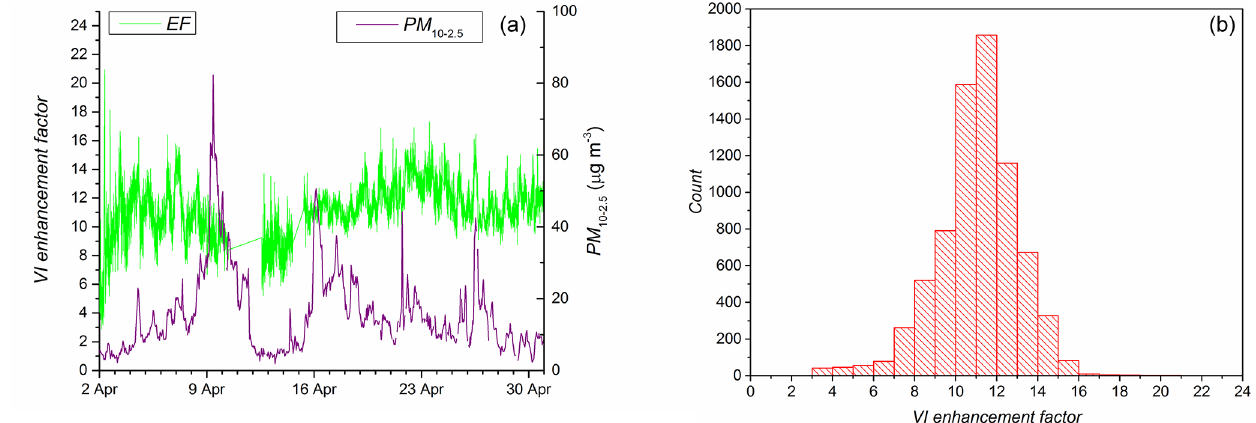
Figure 5. Time series of the virtual impactor enhancement factor calculated from aerodynamic size distributions measured by APS (a) for the PM 10 aerosol fraction. The enhancement factor frequency distribution is shown on the right (b) .